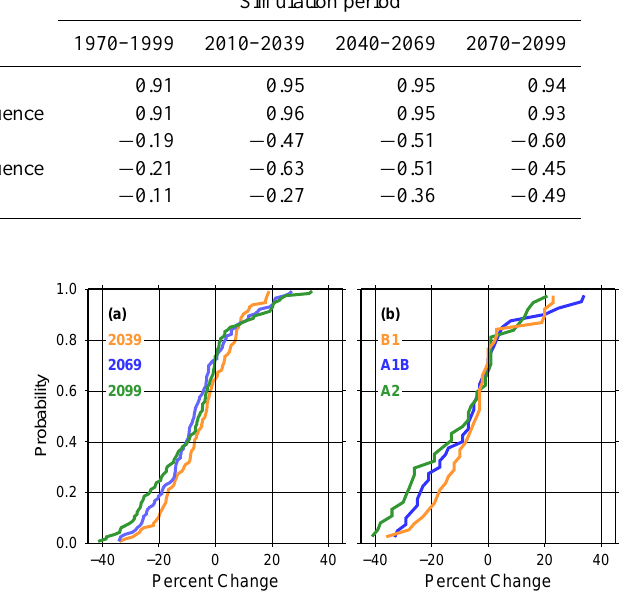
Simulation period